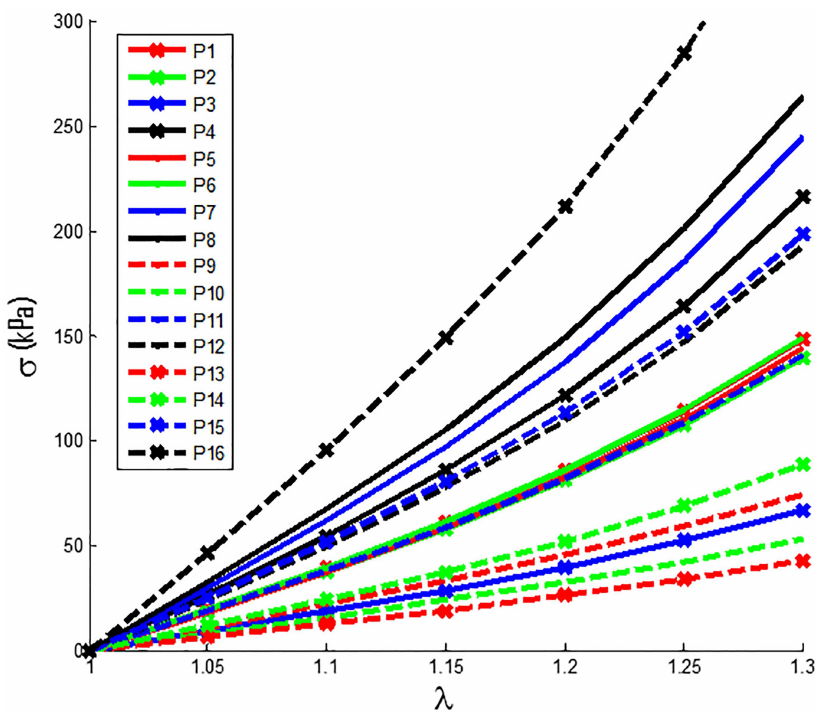
Fig 6. Stress-Stretch curves of Mooney-Rivlin Models for the 16 plaque samples. Each curve used averageparameter values for all availableslices for the given plaquesample.